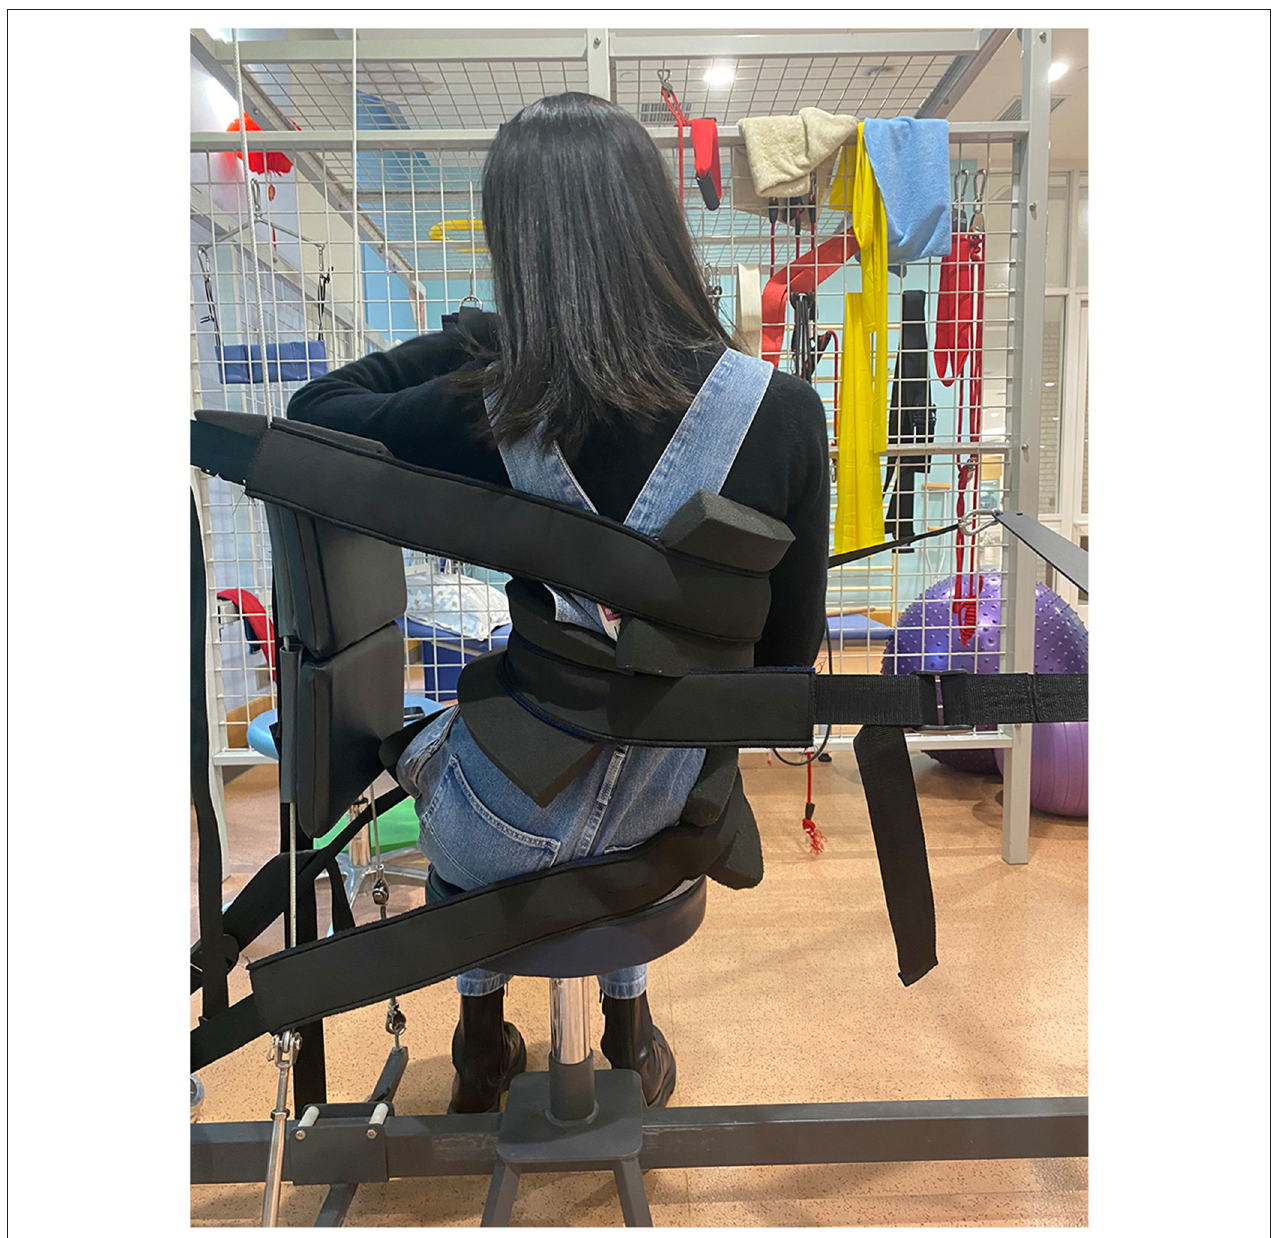
FIGURE 2 | Traction set-up. Patient seated. Pelvic stabilization to prevent any pelvic displacement. Patient performed the appropriate corrective movements then L3 was pulled from the left. Her ribcage was stabilized to prevent any further displacements. Traction was performed for